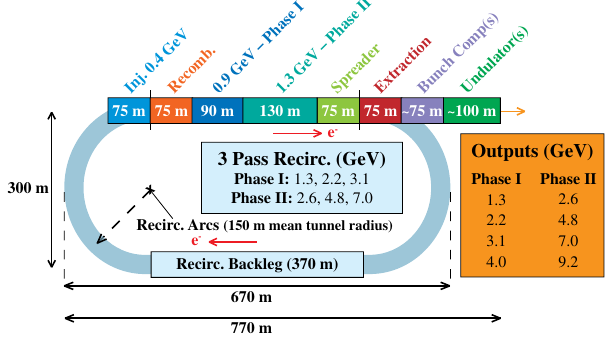
FIG. 1 (color online). Conceptual layout of a recirculated SRF